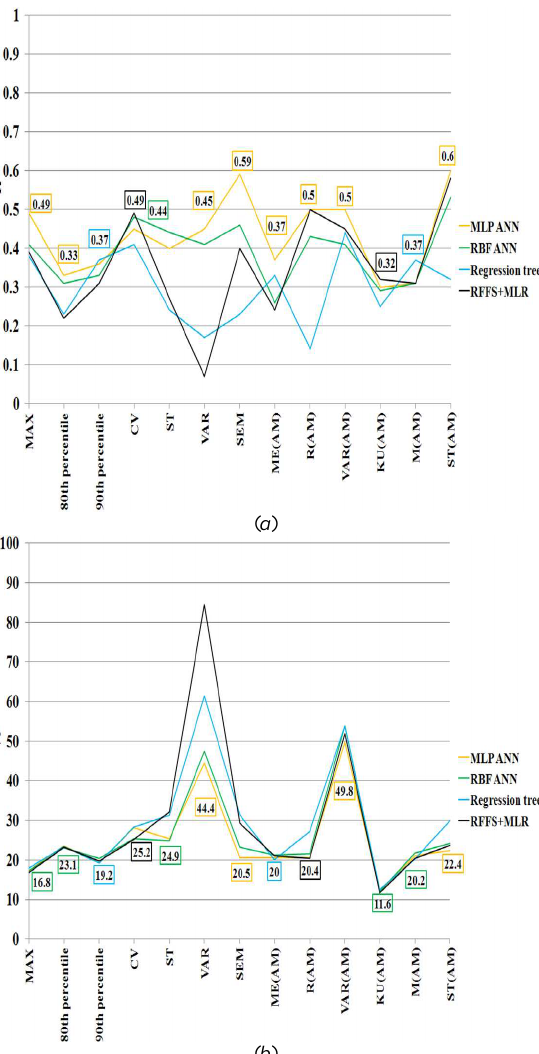
Figure 2. ( a ) and ( b ) are respectively R 2 and relative error results derived from individual machine learners using SPOT-5 textural data. The colour of the box surrounding the values refers to the method used to derive the value inside the